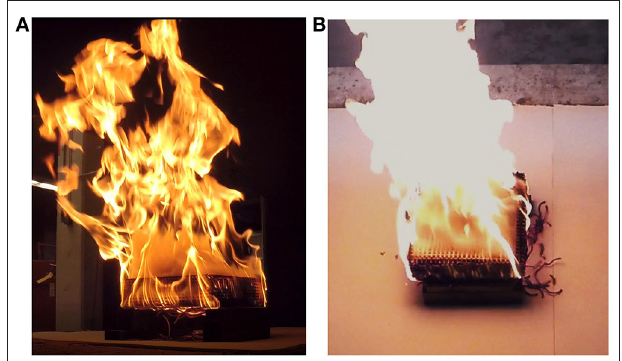
FIGURE 4 | Densely-packed crib (crib design #22) from the side (A) and from above (B) burning in a quiescent environment. The crib burns primarily from the outside inward, with lots of unburnt, white gases being emitted from the top of the fuel bed. Figures 6 – 8 plot the normalized burning rate results as a function of wind speed for the 1.27, 0.64, and 0.32 cm thick sticks, respectively. All data are scaled by the exposed surface area (A s ) and the inverse square root of the stick thickness (b − 0.5 ) as in Block (1971) and Heskestad (1973). Each point represents the average of three tests, and though it may not be visible